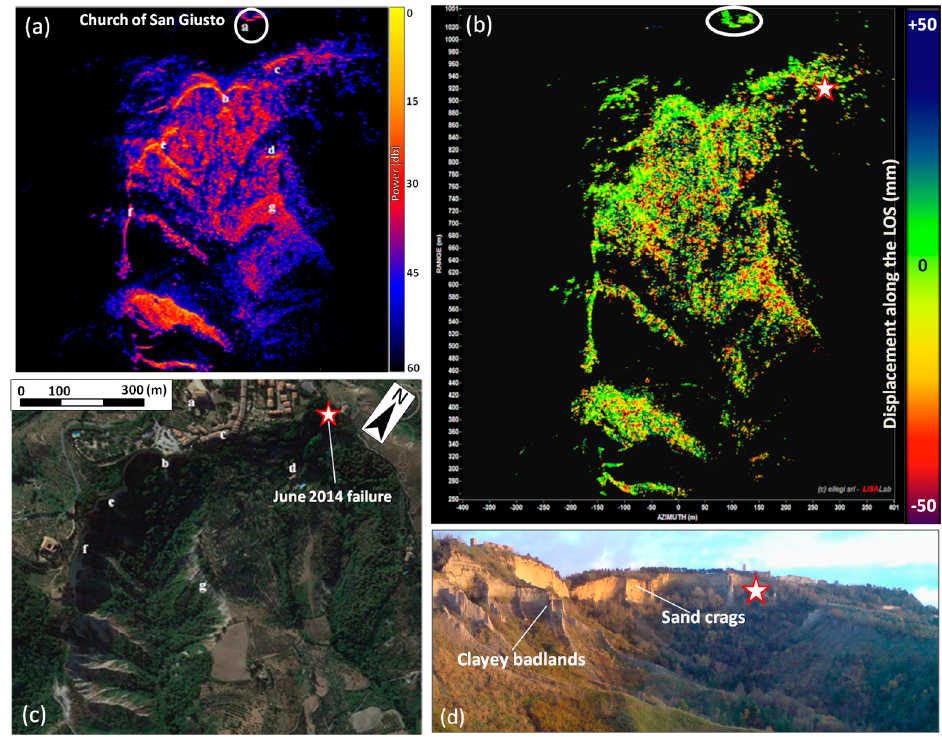
Figure 8. GB-InSAR 2 monitoring data. ( a ) SAR power image of the scanned area: a = Church of San Giusto; b, c, e, f = crags sandy cliffs; ( b ) monitoring period SAR cumulated displacement map: stable areas in light green, areas characterized by displacement toward the sensor LOS (colors from yellow to purple), areas characterized by displacements away from the sensor LOS (colors from dark green to blue); red star highlights the sand-cliff failure; white circle locates the Church of San Giusto; ( c ) geographical location of the monitored Le Balze geosite, letters same as in ( a ); red star = sandy wall collapse on June 2014 ( d ) Picture of Le Balze geosite.